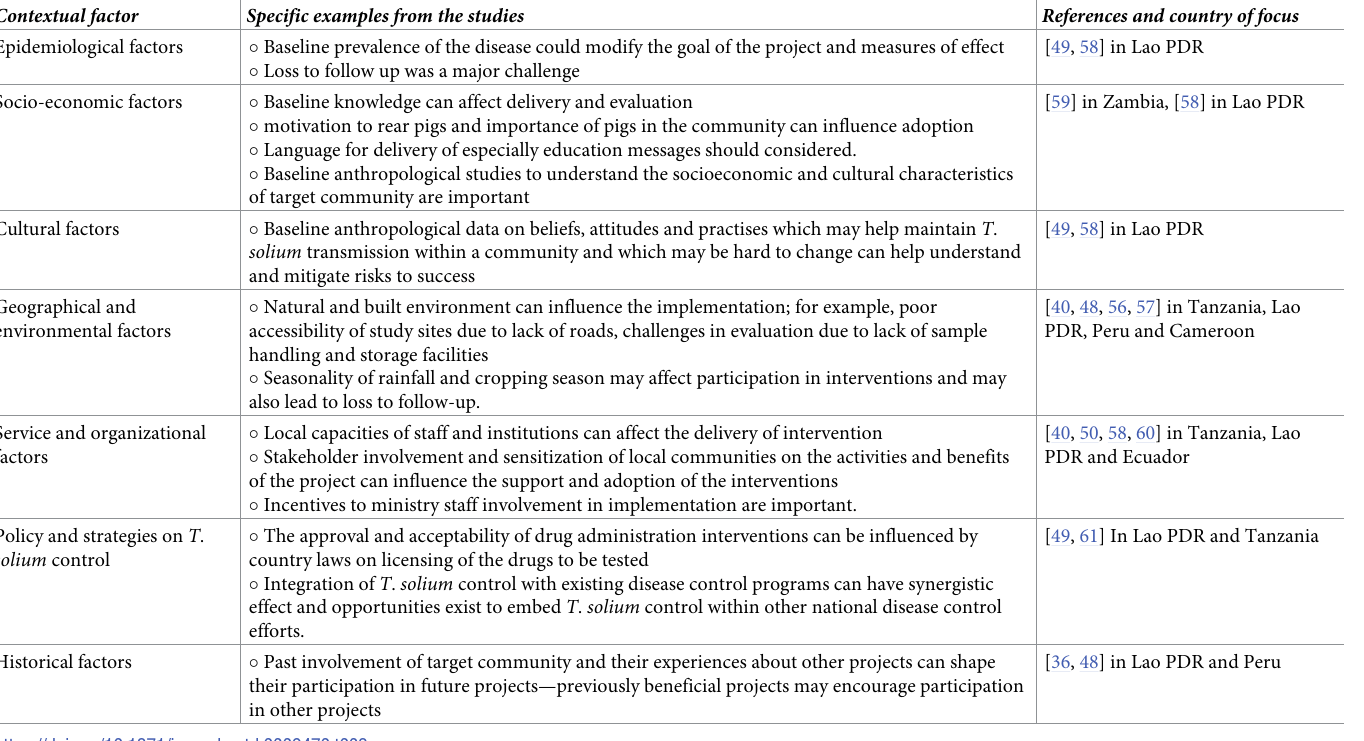
Table 3. Summary of contextual factors analysis for effectiveness